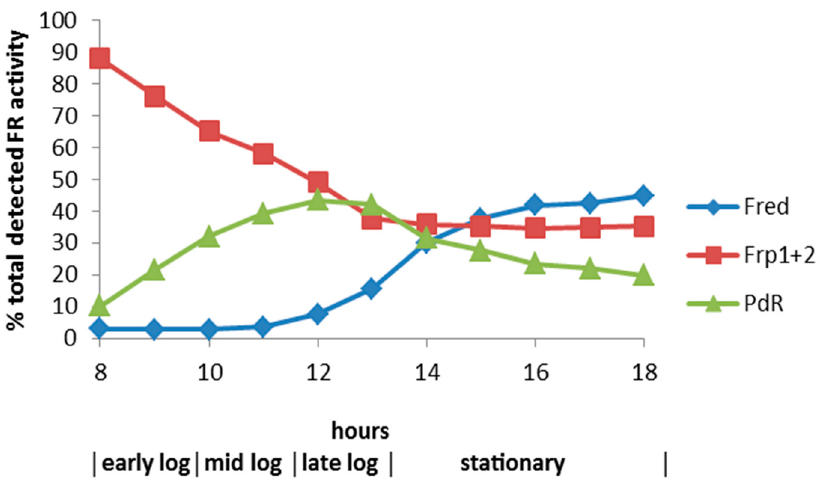
Figure 2. Relative contribution of the different assayed FNR-generating enzymes to the total DKCMO-supporting flavin reductase activity titre throughout the various phases of ( rac )-camphor-dependent growth of P. putida ATCC 17453. Adapted from Figure 7 [20].